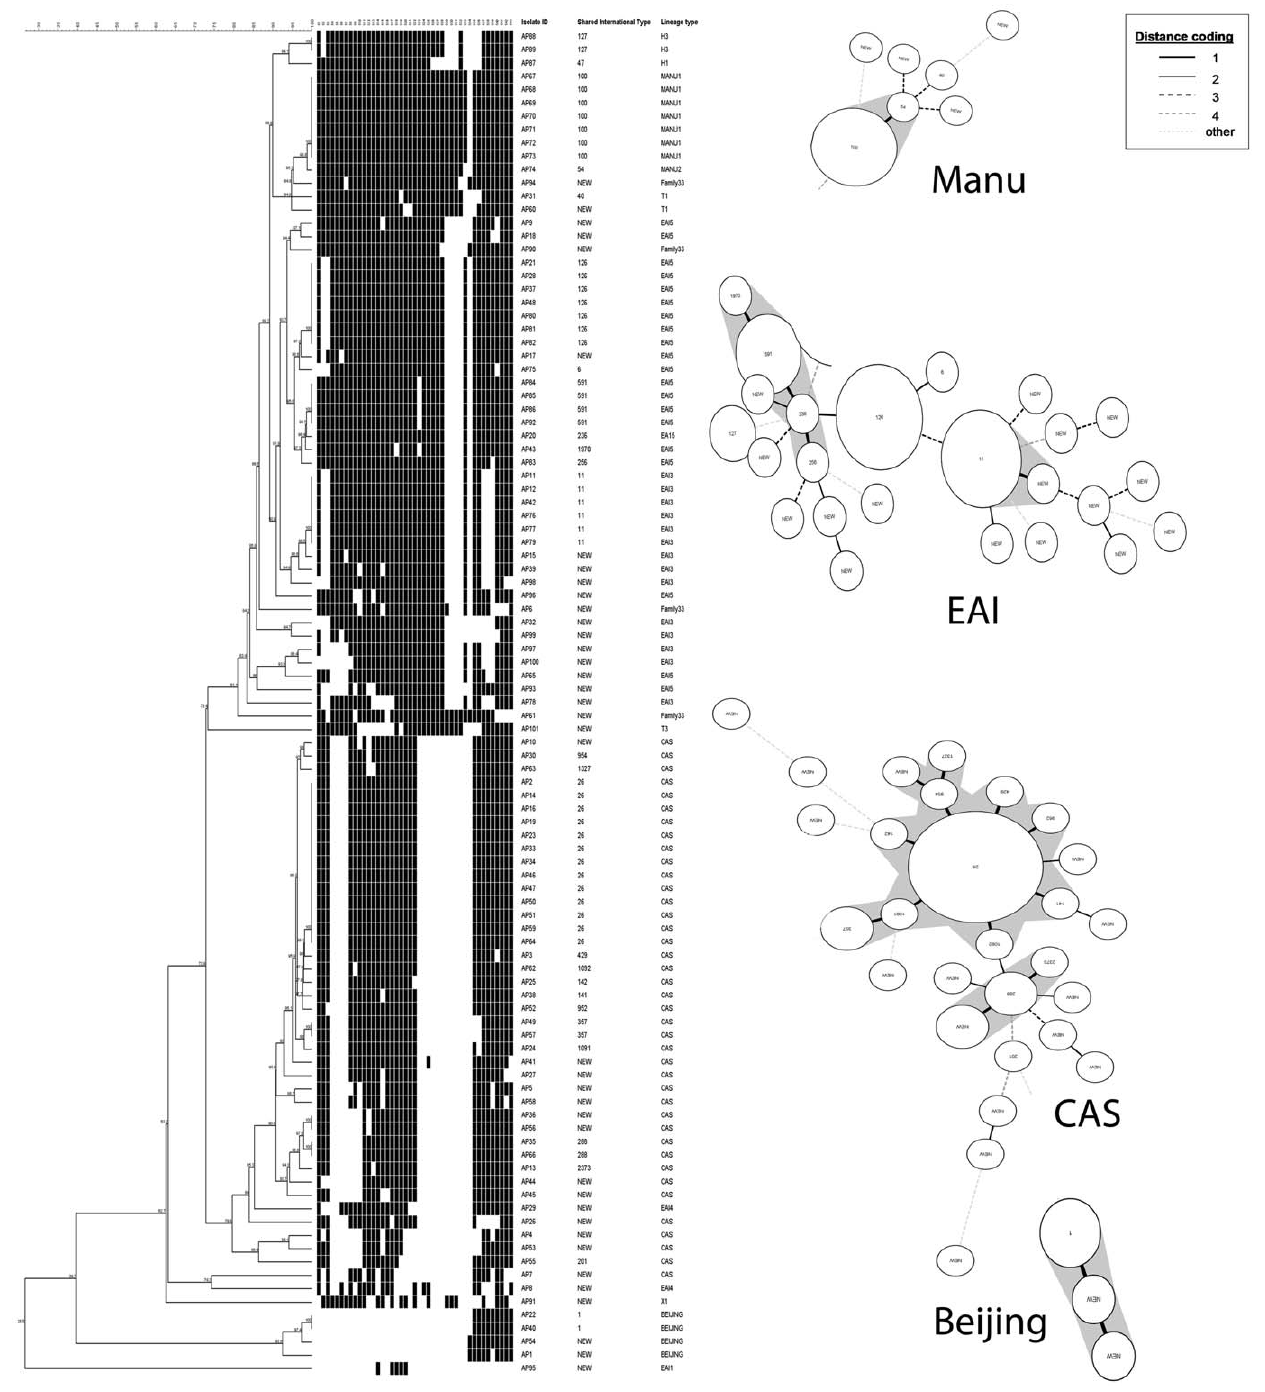
Figure 1. Genetic affinities within the M.tuberculosis isolates based on spoligotyping. Different clades corresponding to prevalent genotypes are prominently highlighted. In the inset is the distance coding convention relevant to the genetic relatedness of different isolates within a clade.